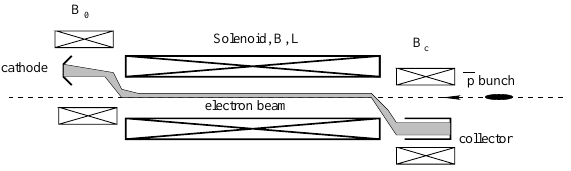
FIG. 2. Layout of the beam-beam compensation